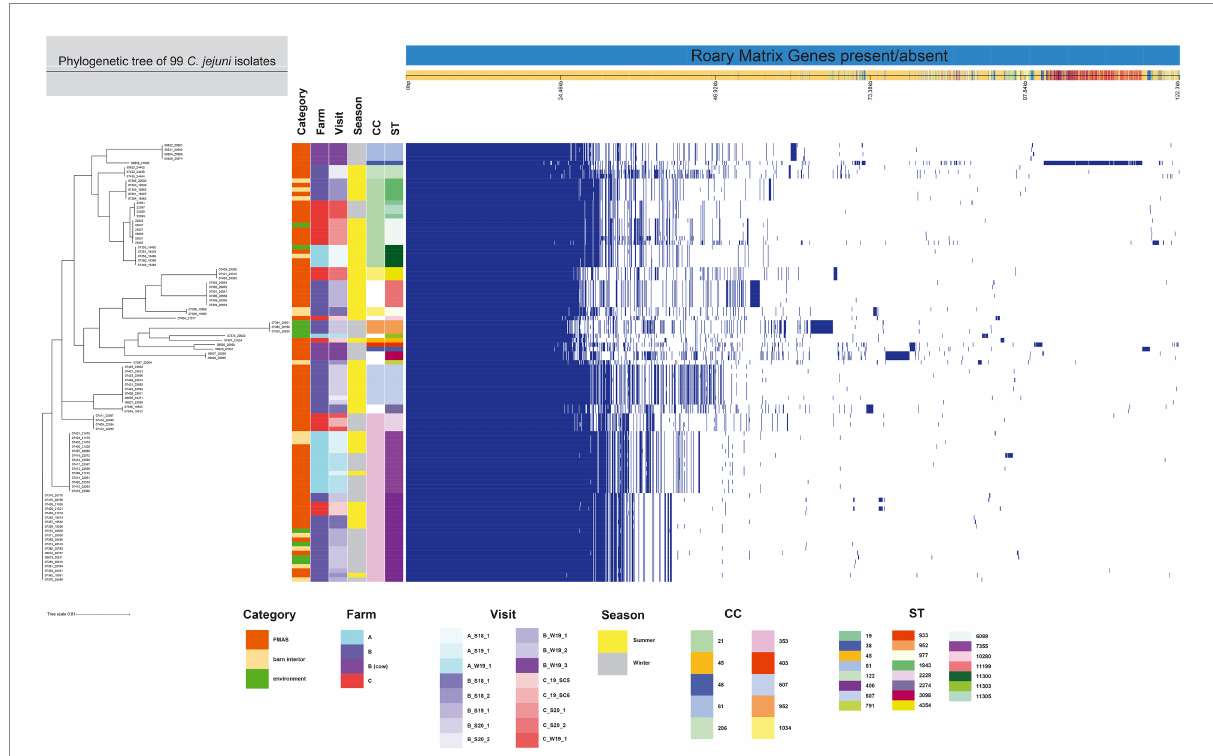
FIGURE 2 The figure was drawn using the phandango.net web application (Hadfield et al., 2017). The left panel shows the maximum likelihood tree of 99 C. jejuni isolates (1,234 genes) based on the alignment of the core-genome calculated with RAxML. The top panel shows a single representative nucleotide sequence (0 bp-122.3 kb); contigs (fragments are colored by similarity) and genes are derived from the pan-genome content. The right panel displays the Roary pangenome sorted from core genes on the left to accessory genes to the right, with presence (blue) or absence (white) of blocks relative to genes and contigs in the pan-genome. The middle features metadata [category, farm, visit, season, Clonal complex (CC), and Sequence type (ST)]. The white blocks represent unassigned CCs and